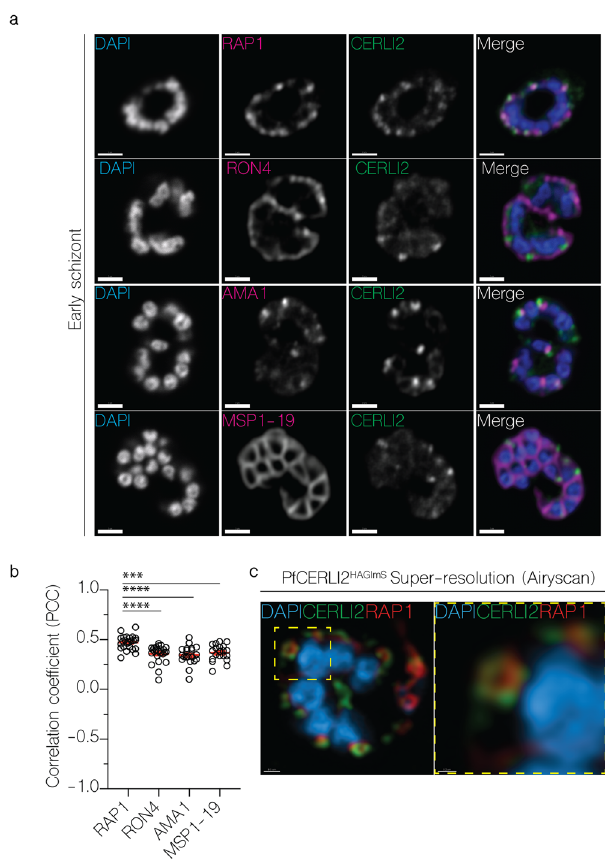
Fig. 4 PfCERLI2 localises to the rhoptry bulb. a 2D Confocal immuno fl uorescence microscopy of early PfCERLI2 HAGlmS schizonts stained with DAPI (nucleus) and anti-HA (PfCERLI2) antibodies, along with antibodies to either RAP1 (rhoptry bulb), RON4 (rhoptry neck), AMA1 (micronemes), or MSP1-19 (merozoite surface). Scale bar = 2 µ m. b Quanti fi cation of colocalisation between PfCERLI2 and the merozoite organelle markers RAP1, RON4, AMA1 and MSP1-19. Colocalisation quanti fi ed as Pearson ’ s correlation coef fi cient (PCC) when the PfCERLI2 signal was de fi ned as the region of interest. n = 3 biological replicates, 6 schizonts per replicate. Error bars = SEM, *** p < 0.001, **** p < 0.0001, by unpaired t -test. c Representative maximum-intensity projection of PfCERLI2 HAGlmS parasites stained with antibodies to RAP1 (rhoptry bulb) and HA (CERLI2) and imaged using the super-resolution microscopy platform Airyscan. Yellow box indicates the zoom area for the right-hand